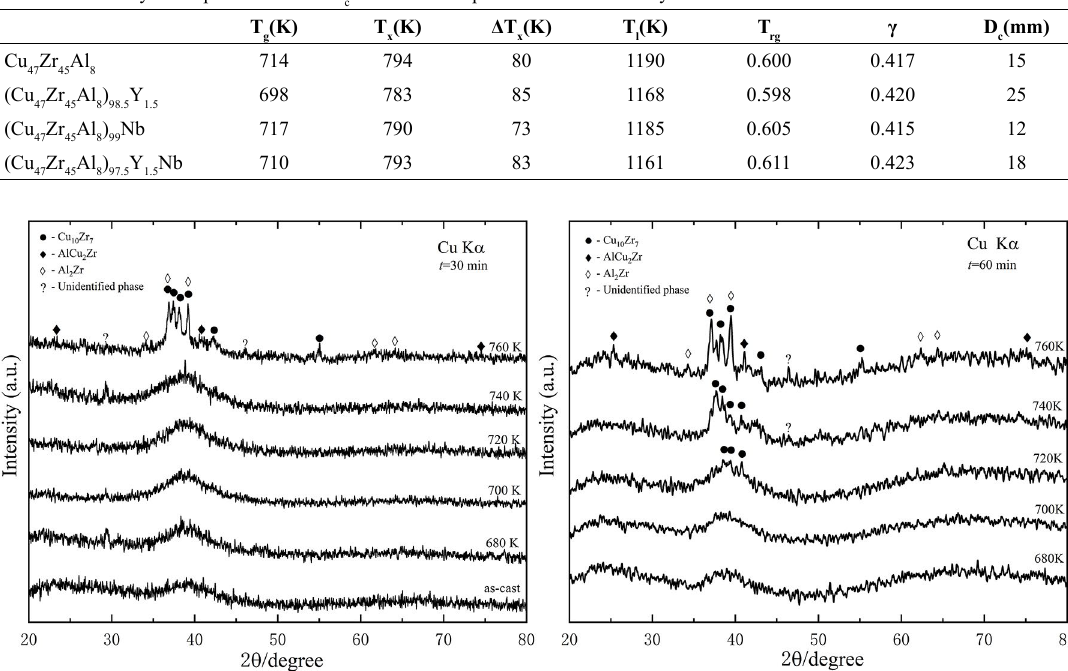
Figure 2. XRD patterns of annealed (Cu